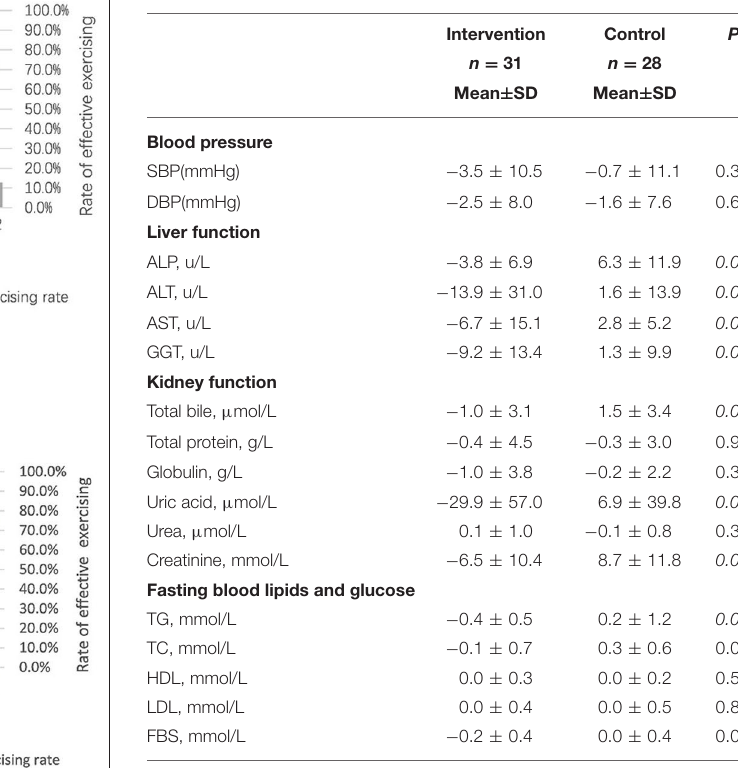
TABLE 4 | Differences in health examinations between intervention and control groups.